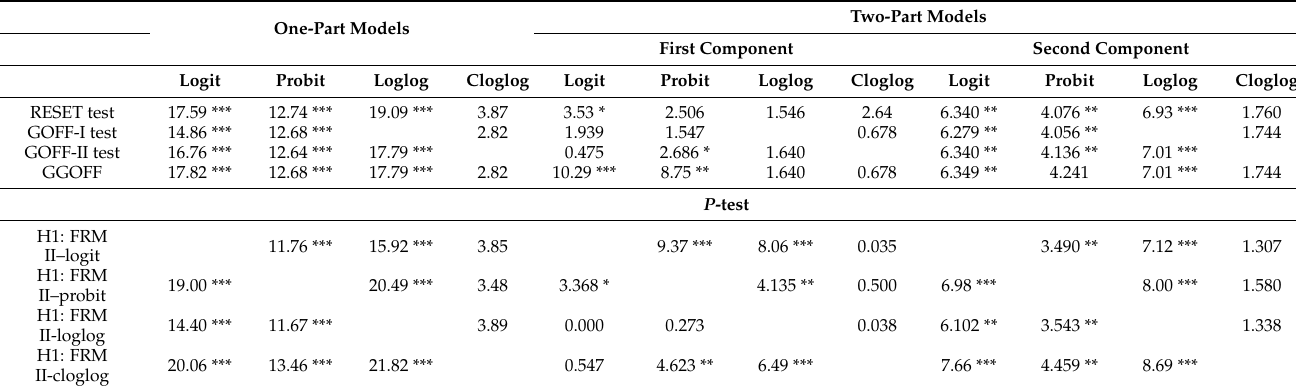
Table 4. Specification tests for the one-part model and two-part models (in its first and second components): 2008–2018 period. Two-Part Models One-Part Models First